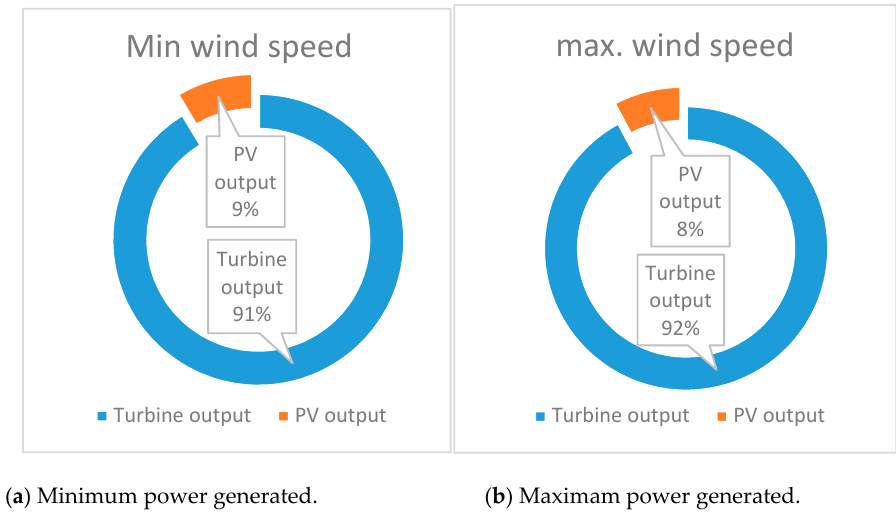
Figure 15. Minimum and maximum power generated in a hybrid system.